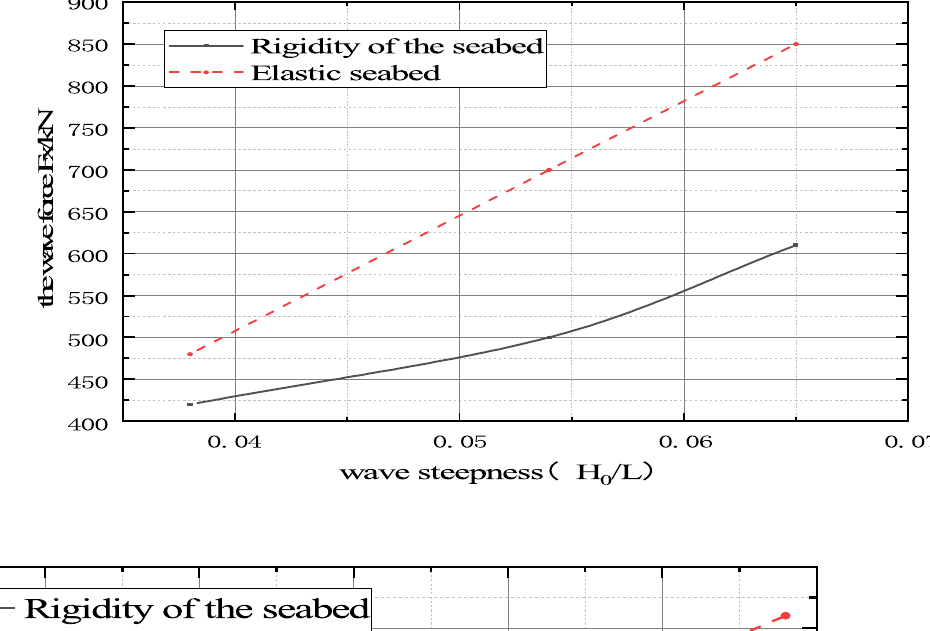
/L ) F change 0 xmax